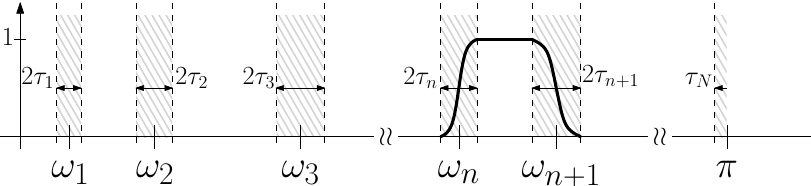
Figure 1. Construction of 1D Empirical Wavelet: given a set of boundaries band-pass filter between ω n and ω n + 1 with transition regions of width 2 τ n and 2 τ n + 1